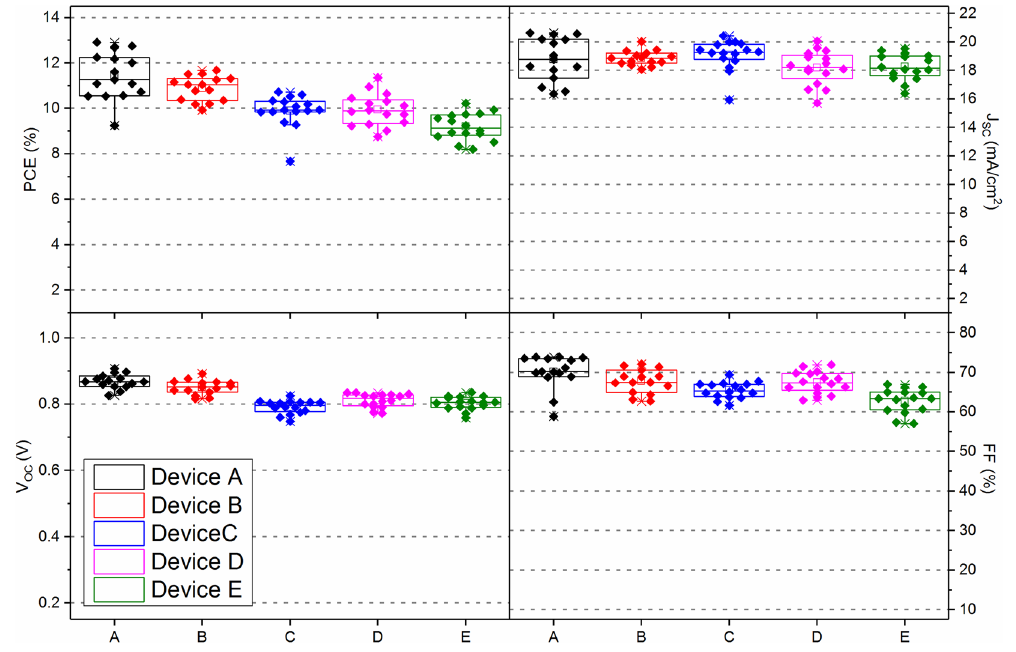
Figure 2. Box plots showing statistical data of PSC performance from devices A–E (see Table 2 for a description of device